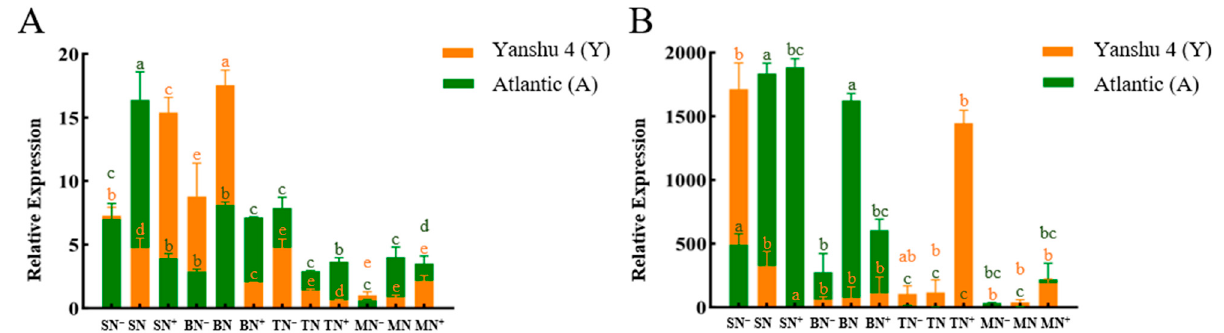
Figure 11. Relative expression of nitrate transporter StNRT1.5 in two genotypes of potato under different N supply levels. ( A ) Leaf (L); ( B ) Root (R). S, B, T, and M represent seedling stage, budding stage, tuber expansion stage, and mature stage, respectively. N − , N, N + are different N supply levels, representing low N, normal N, and excess N, respectively. Different letters indicate the difference of relative gene expression in different periods under different N application levels ( p < 0.05).